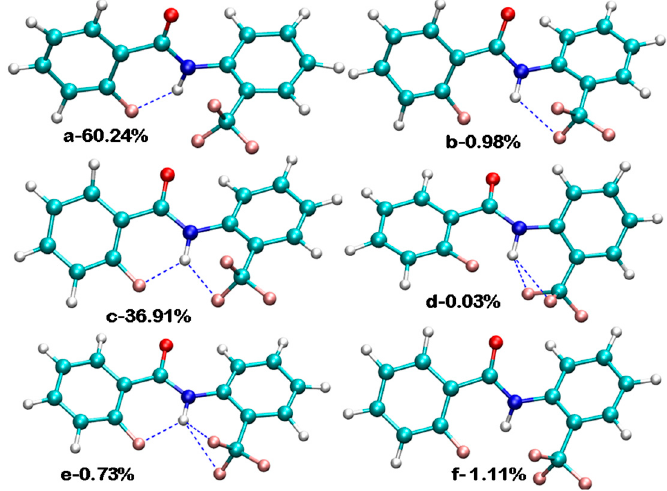
Figure 11. Various possibilities of HB formation for molecule 5 , with their % of occurrence obtained from the MD simulations (HB is shown by blue line).